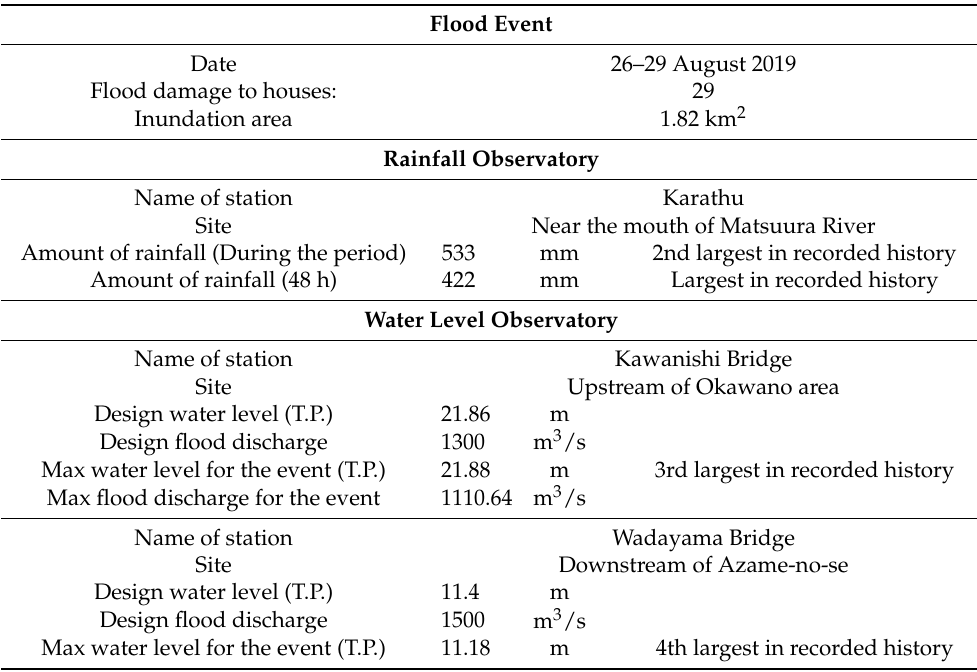
Table 6. Observation status at the time of flood event